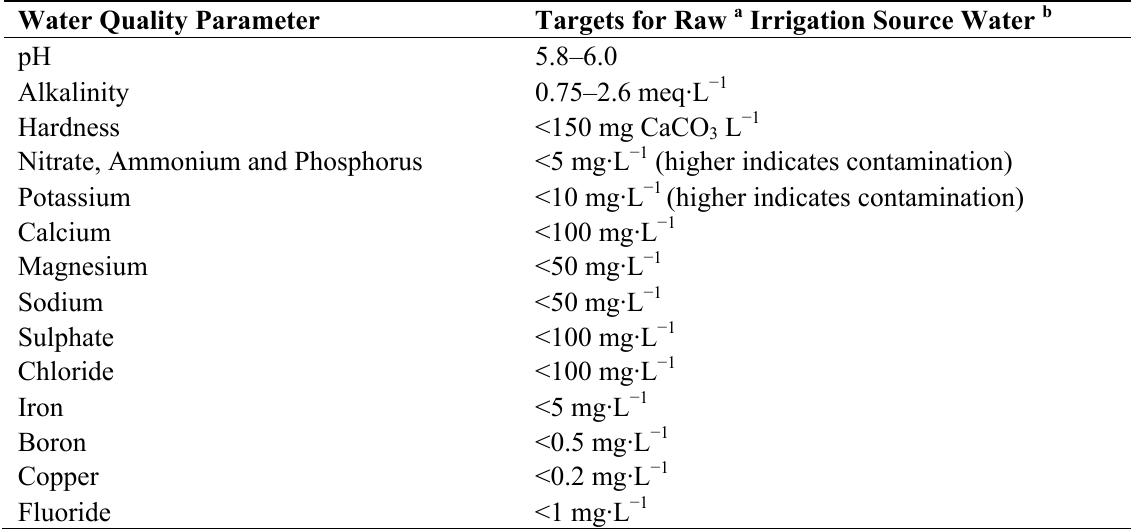
Table 1. Water quality targets for raw irrigation water